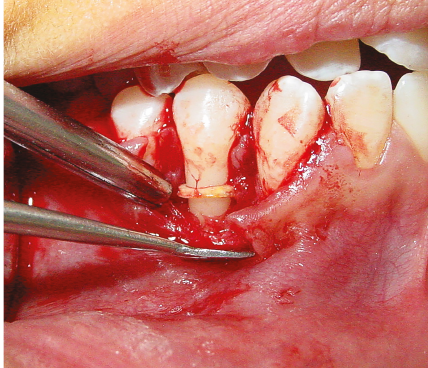
Figure 5: The orthodontic elastic band found.